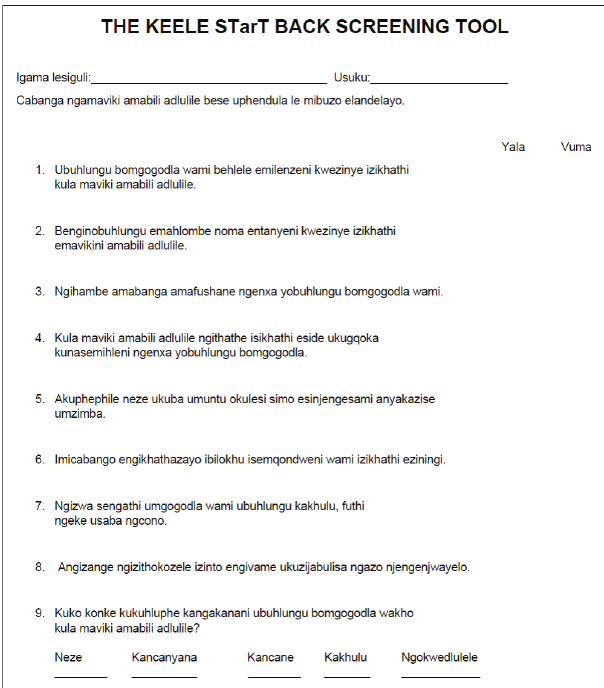
FIGURE 5: isiZulu STarT back screening